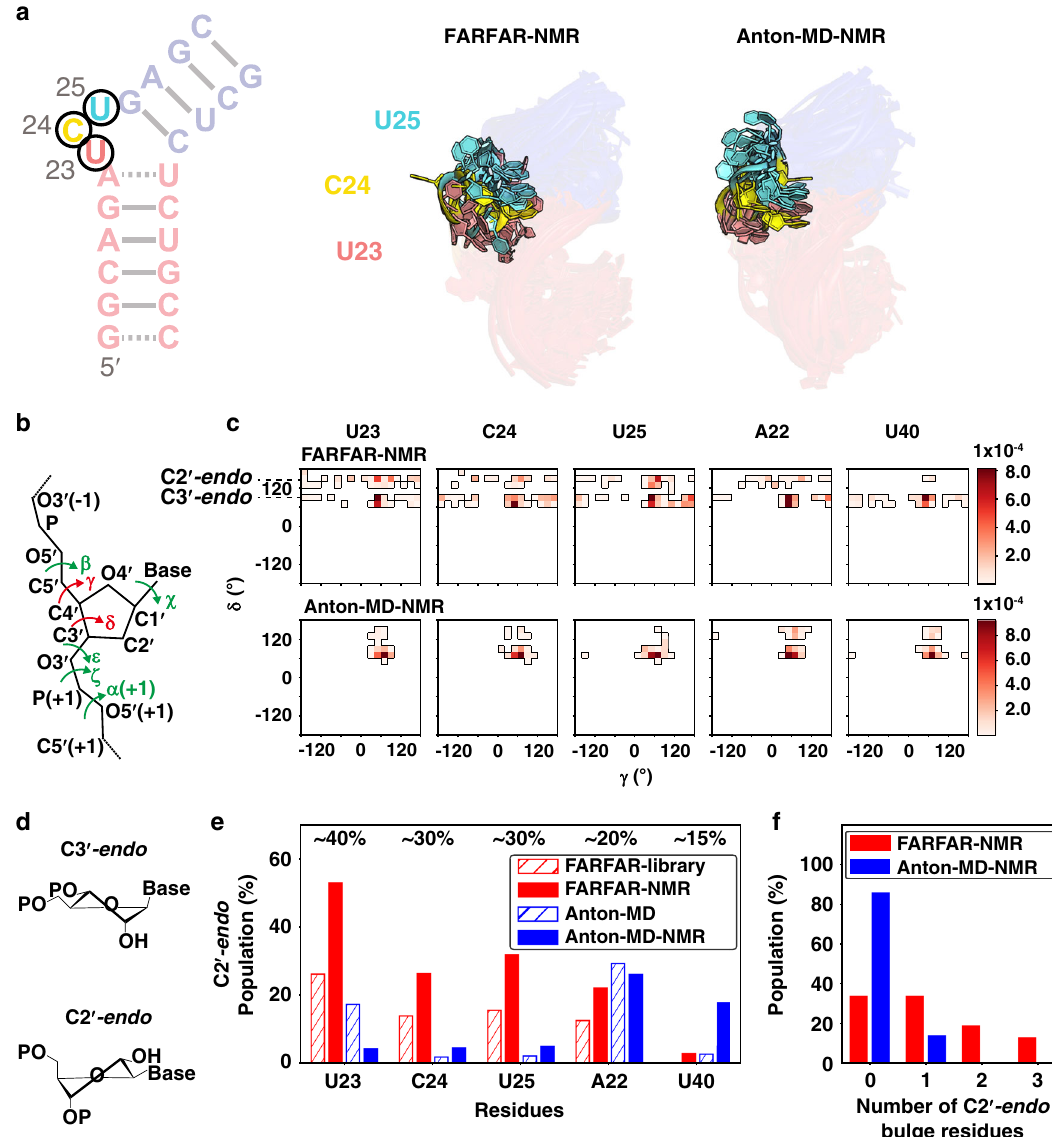
Fig. 4 FARFAR-NMR ensemble broadly samples non-canonical sugar-backbone torsion angles relative to Anton-MD-NMR. a Overlay of the dynamic ensembles of the TAR bulge. b RNA backbone torsion angles exhibiting different and similar distributions between Anton-MD-NMR and FARFAR-NMR are colored red and green, respectively ( “ Methods ” ). c 2D density maps of δ versus γ comparing Anton-MD-NMR and FARFAR-NMR ensembles ( N = 2000) for bulge residues as well as A22 and U40. The bin width is 20°. d Structure of the ribose moiety in C3 ′ - endo and C2 ′ - endo conformations. e Population of C2 ′ - endo pucker at bulge residues as well as A22 and U40 in the FARFAR-library ( N = 10,000, red open), FARFAR-NMR ( N = 20 × 100 = 2000, red fi ll), Anton-MD library ( N = 10,000, blue open) and Anton-MD-NMR ( N = 20 × 100 = 2000, blue fi ll). Experimental estimates of the C2 ′ - endo population based on 13 C chemical shifts are indicated above the bars ( “ Methods ” ). f The population of conformers in the ensemble as a function of the number of C2 ′ - endo bulge residues for FARFAR-NMR (red, N = 20 × 100 = 2000) and Anton-MD-NMR (blue, N = 20 × 100 =